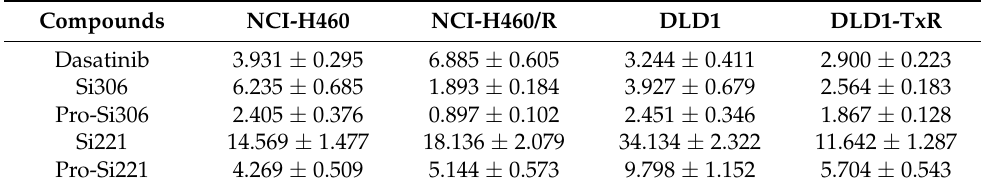
Table 1. Decrease in cell viability induced by SFK inhibitors (presented as IC 50 in µ